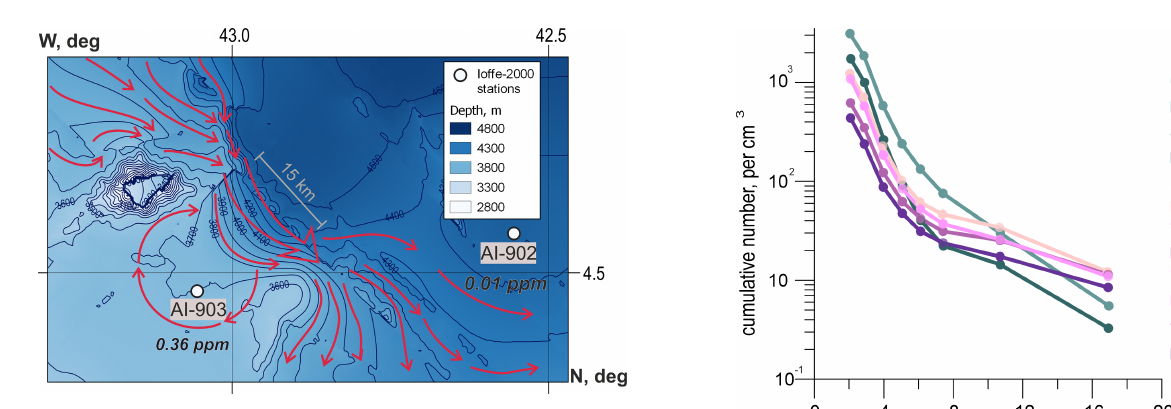
Figure 7. The Ceara Rise SPM maximum: bottom topography (GEBCO Bathymetric Compilation Group, 2020) and the Deep Western Boundary Current (red lines). Figure 8. Cumulative particle number distribution for AI-868 sta- tion showing both “old” suspension in the upper ocean with the slope of the distributions close to − 3 and “fresh” in the water col- umn with steep slopes about − 2. Station AI-868 is a part of the SPM-rich “vertical anomaly”. The x axis is particle diameter; the y axis is cumulative particle number in log10